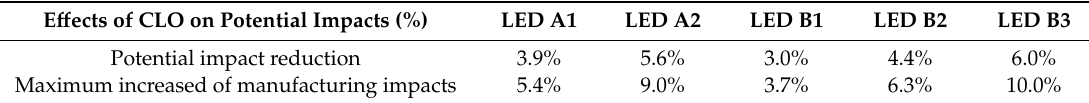
Table 5. Potential impact reduction and increase of manufacturing impacts with CLO. E ff ects of CLO on Potential Impacts